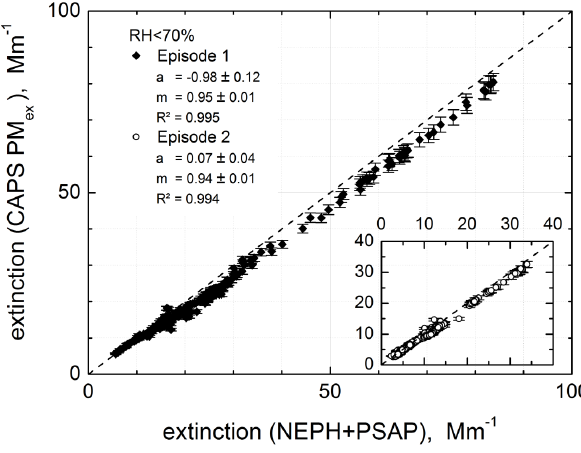
Figure 12. Ratio of extinction reported by CAPS PM ex to extinction calculated from NEPH+PSAP for the entire range of extinction coefficients measured for laboratory and ambient aerosols. Ambient aerosol data are 10 min average values with its error bars indicating the ± 3% uncertainty range of CAPS PM ex data; error bars of test aerosol data refer to the 1- σ of the mean for respective averaging